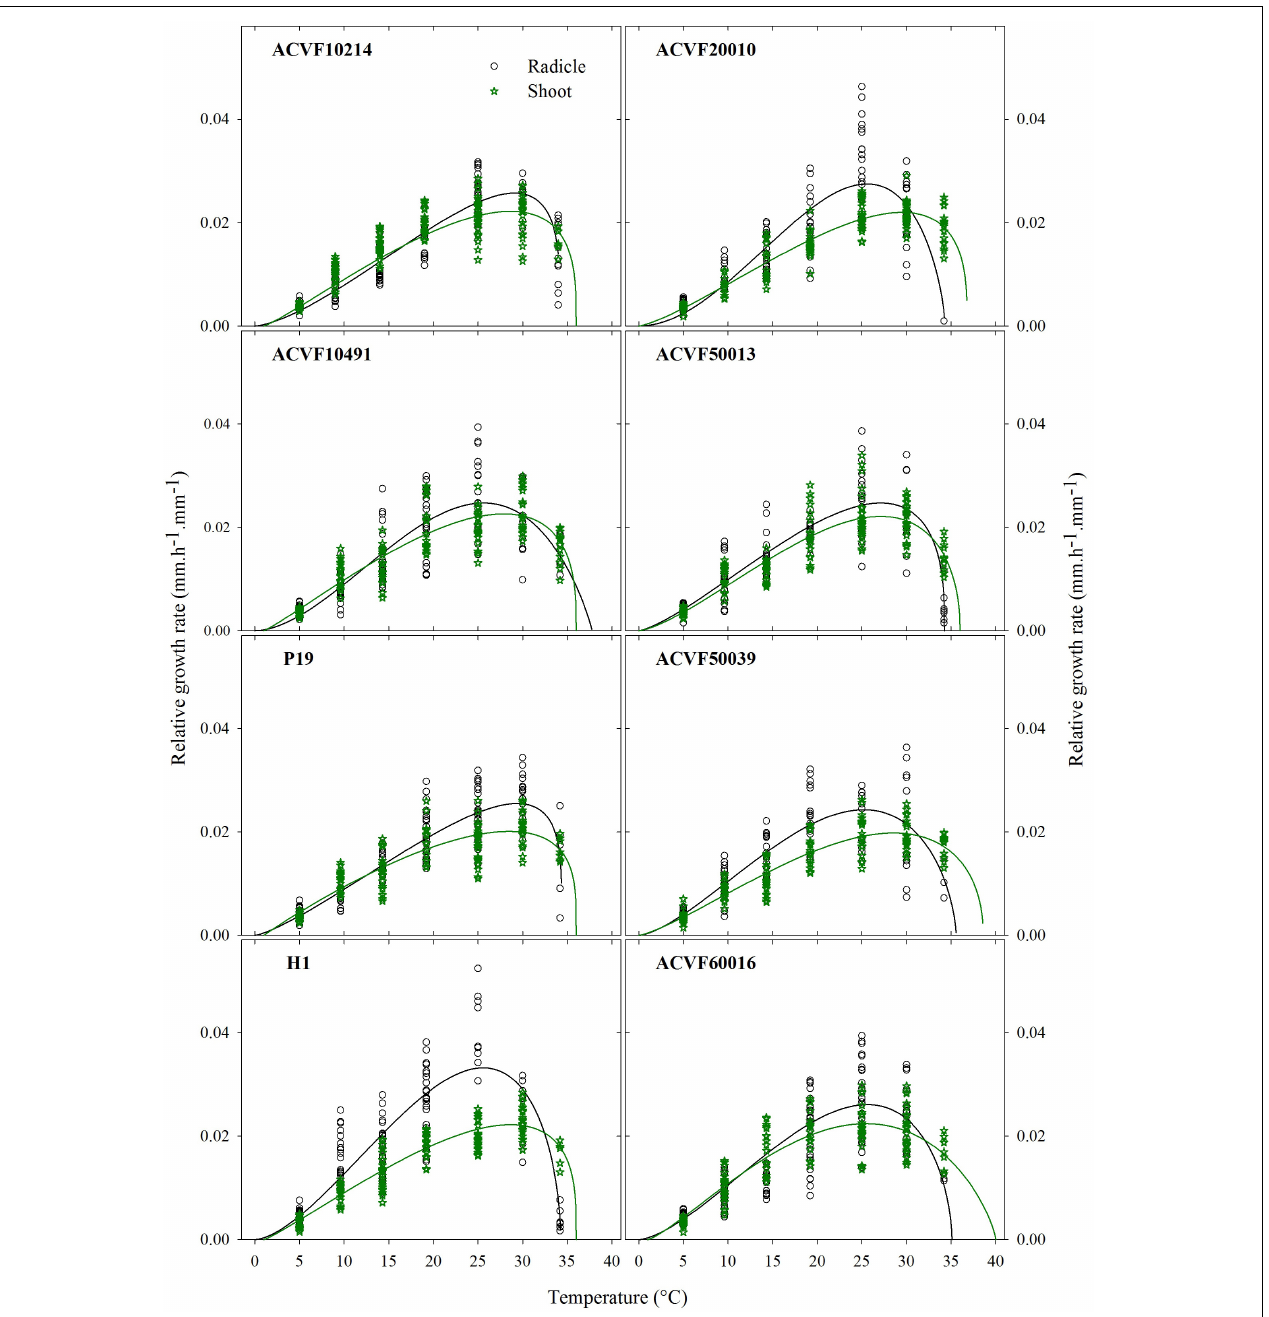
FIGURE 7 | Relative growth rate of radicle and shoot were observed for eight accessions of Lolium perenne during heterotrophic growth in response to a constant temperature. For each temperature between 5 and 35 ◦ C, n = 30. For 40 ◦ C, 0 ≤ n ≤ 30 because of seedling